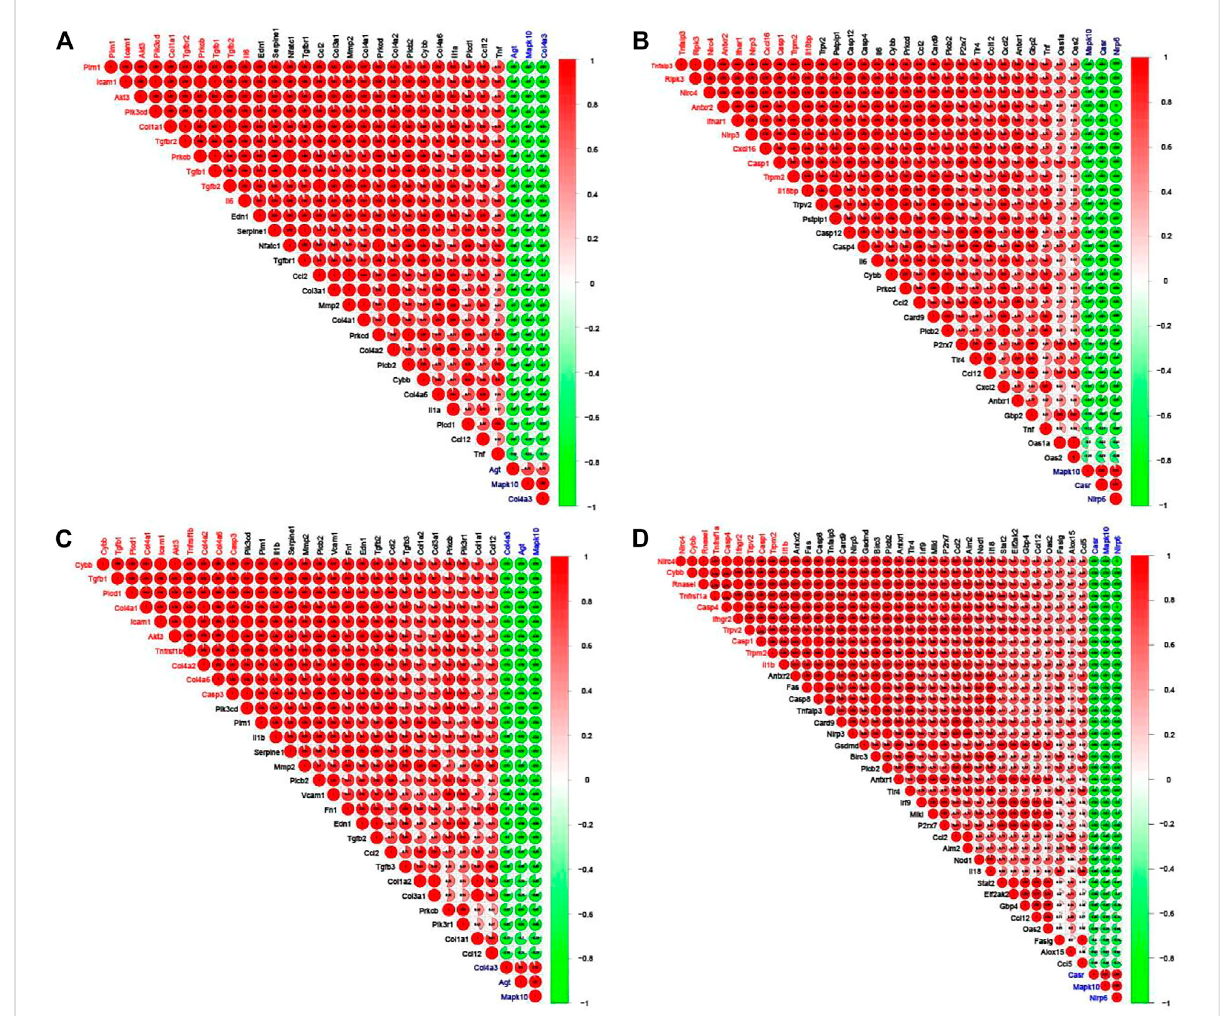
FIGURE 7 CorrplotsofthecorrelationanalysisbetweentheRF-relatedDEGs.Redandgreendenotedpositiveandnegativecorrelation,respectively.Every correlation coef fi cient was represented, and the darker the color, the higher the correlation coef fi cient. Top 10 DEGs with the number of positive correlation coef fi cient > 0.7 were labeled red and top 3 DEGs with the number of negative correlation coef fi cient > 0.7 were labeled blue. (A) The corrplot of RF-related DEGs from the AGE-RAGE pathway in the adenine model. (B) The corrplot of RF-related DEGs from NOD-like receptor pathway in the adenine model. (C) The corrplot of RF-related DEGs from the AGE-RAGE pathway in the UUO model. (D) The corrplot of RF-related DEGs from NOD-like receptor pathway in the UUO